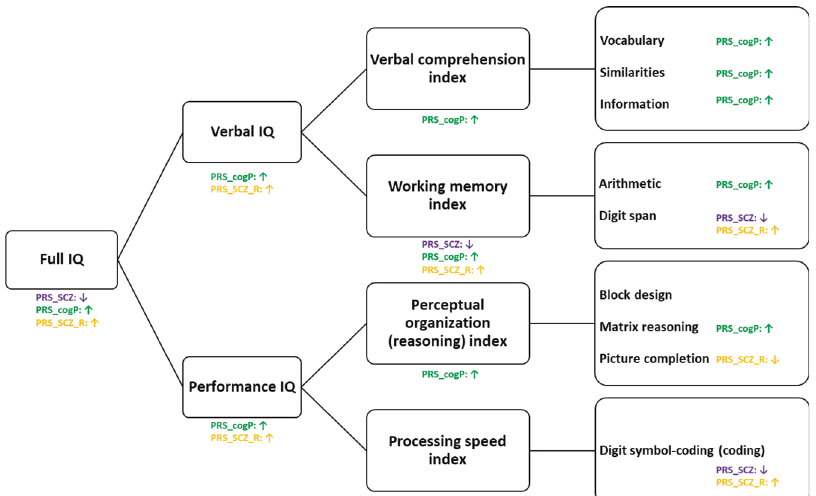
Fig. 1 Effect of the three PRS on the WAIS subtests. Note: The signi fi cant association with PRS of schizophrenia, cognitive performance and resilience are shown in color codes (purple, green and yellow respectively). The arrow direction ↓ implicates a negative correlation, while ↑ implicates a positive